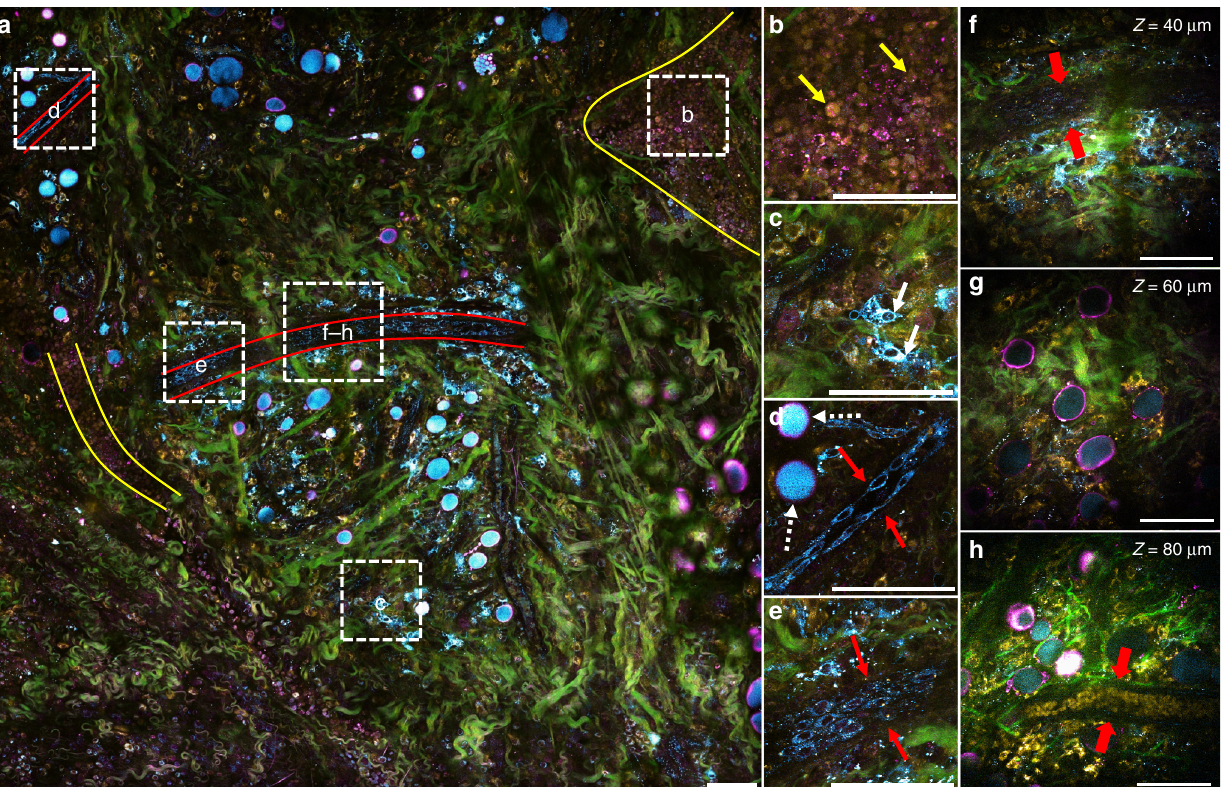
Fig. 2 Tumor microenvironment of a living rat by SLAM microscopy. Pseudo-color presentation in the overlay image (consistent throughout this paper): green — SHG (collagen fi bers); magenta — THG (interface); yellow — 2PAF (FAD); cyan — 3PAF (NADH). a Full view of a large fi eld (1.5 × 1.5 mm 2 ) at the tumor boundary, with different regions of interest (white dashed squares) magni fi ed in b – e . Tumor cell clusters are highlighted with yellow boundaries and vasculatures with red boundaries. b 10-micron tumor cells (yellow arrows) with co-localized 2PAF (yellow, FAD) and THG (magenta, interface) signals. c Larger (>20-micron) cells (white arrows) with strong 3PAF (cyan, NADH) signals, which are likely to be macrophages due to their irregular cell shape and oval-shaped nucleus. d , e Vascular endothelial cells (red arrows) and adipocytes with THG-strong boundaries and NADH-strong content inside (white dashed arrows). f – h Images acquired from different depths at the center of a , with f displaying a hollow vessel composed of a layer of endothelial cells but no signs of red blood cells and h exhibiting a mature vessel fi lled with red blood cells. Contrast in h was intentionally brightened to show blood cells in deeper layers. Raw images can be found in Supplementary Fig. 4. Scale bar: 100 µ m